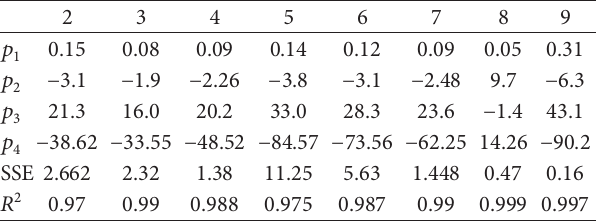
Table 2: The data fitting polynomial equation coefficients and coefficients of evaluation of internal contours of the Himalayan marmot’s second front